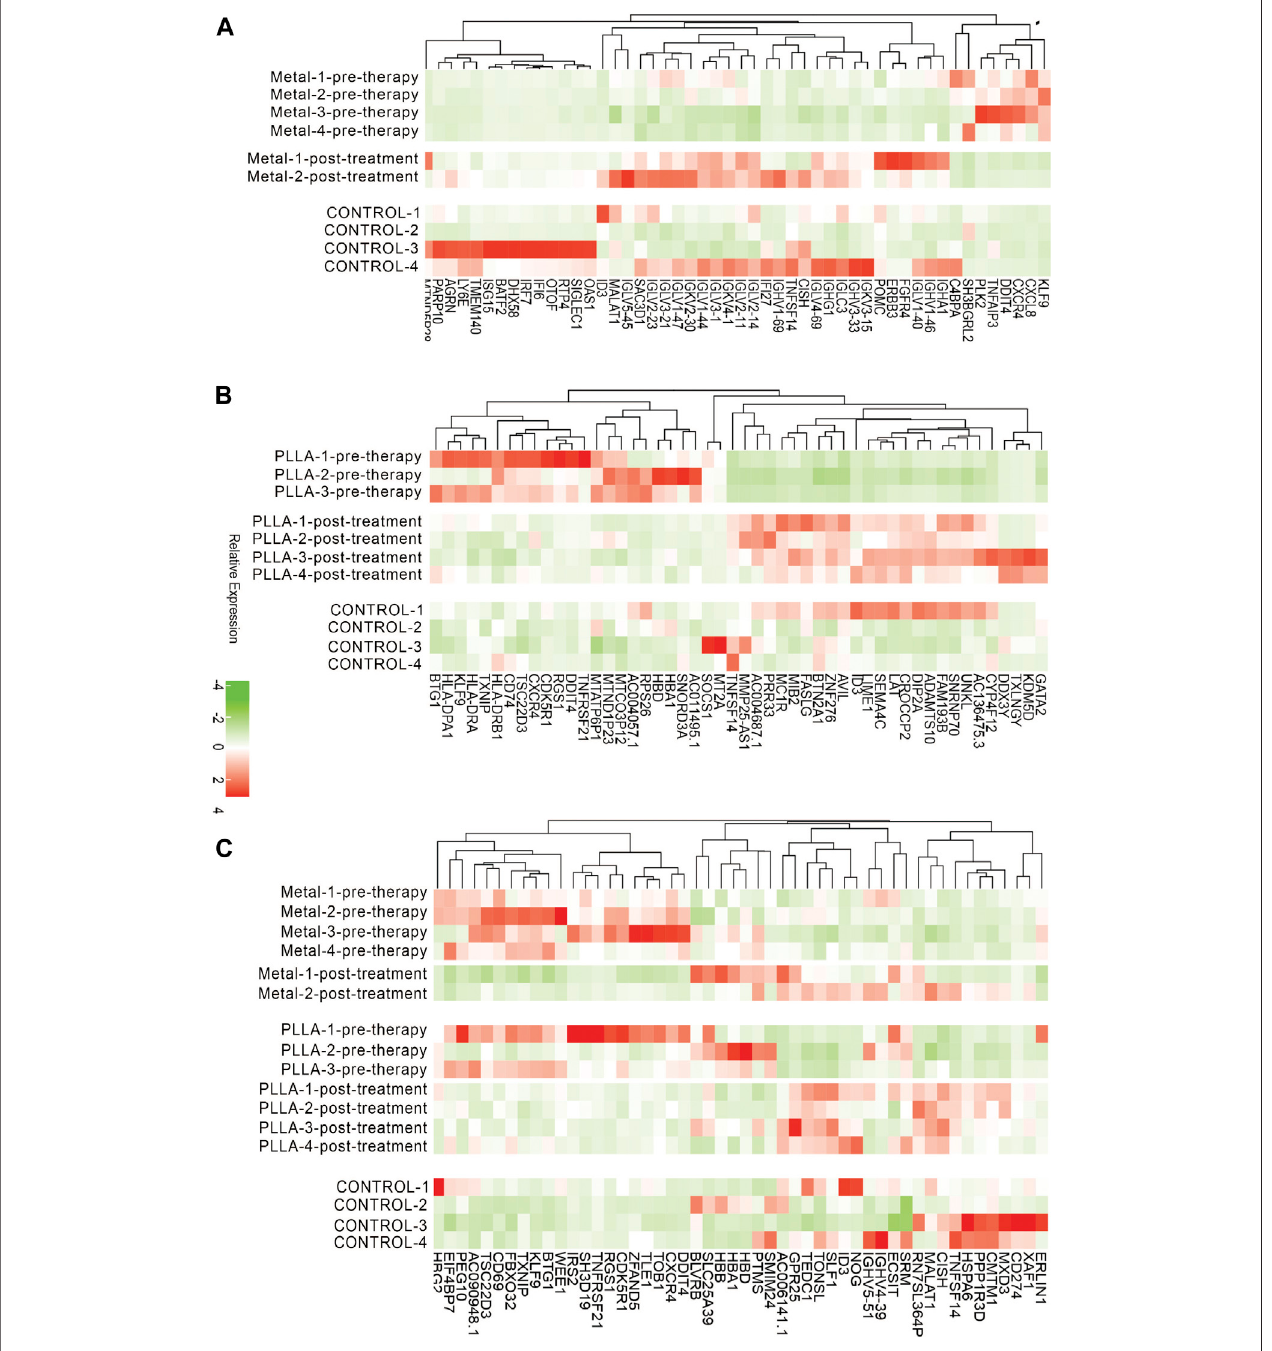
FIGURE 2 | Expression levels of DEGs from metal and PLLA device groups. (A) Color key of the heatmap shows the relative expression level of DEGs in metal device pre-therapy group vs. post-treatment group. (B) Heatmap showing DEGs in PLLA device pre-therapy group vs. post-treatment group. (C) Heatmap of overlap DEGs between metal and PLLA device